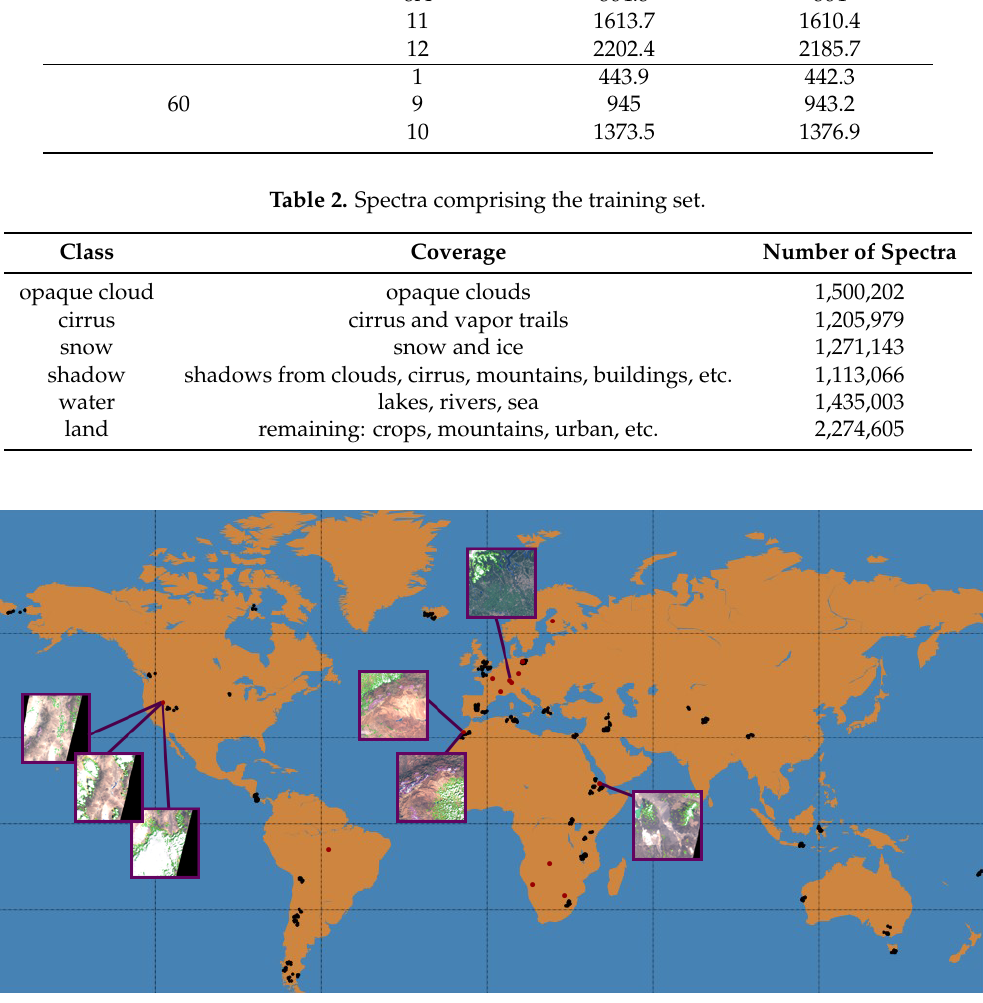
Figure 1. Location of the images of the training set (black circles) and the test set (red circles). The thumbnails depict cases with bright non-cloud